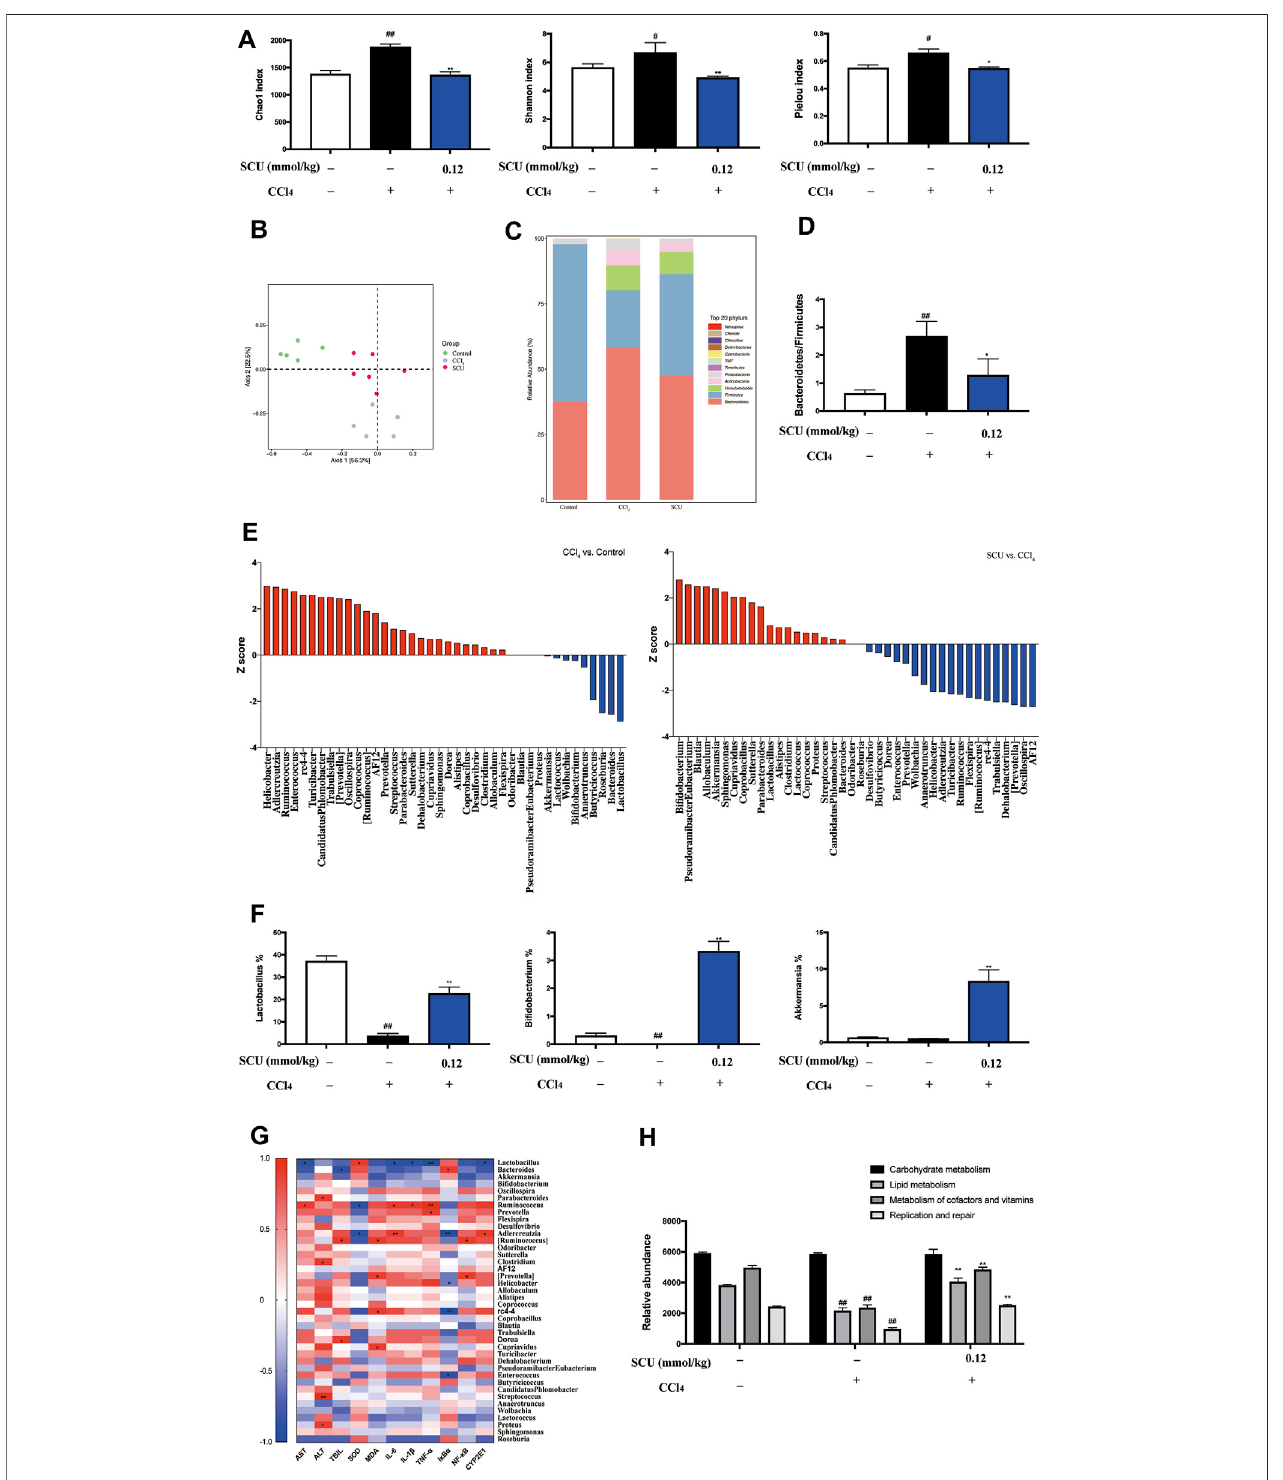
FIGURE 4 | SCU modulated gut microbiota (A) Chao1, Shannon, and Pielou index. (B) PCoA of gut microbiota. (C) Bacterial taxonomic at phylum level. (D) Bacteroidetes-to-Firmicutes ratio. (E) Z score analysis. (F) Selected three genera. (G) Spearman correlation analysis between gut microbiota and liver injury indicators, (*, **)indicates asigni fi cantcorrelation( p < 0.05, p < 0.01). (H) Prediction ofmicrobiome functionbasedon theKEGG database.( n (cid:1) 5). # p < 0.05, ## p < 0.01vs. control group; * p < 0.05, ** p < 0.01 vs. CCl 4 group.